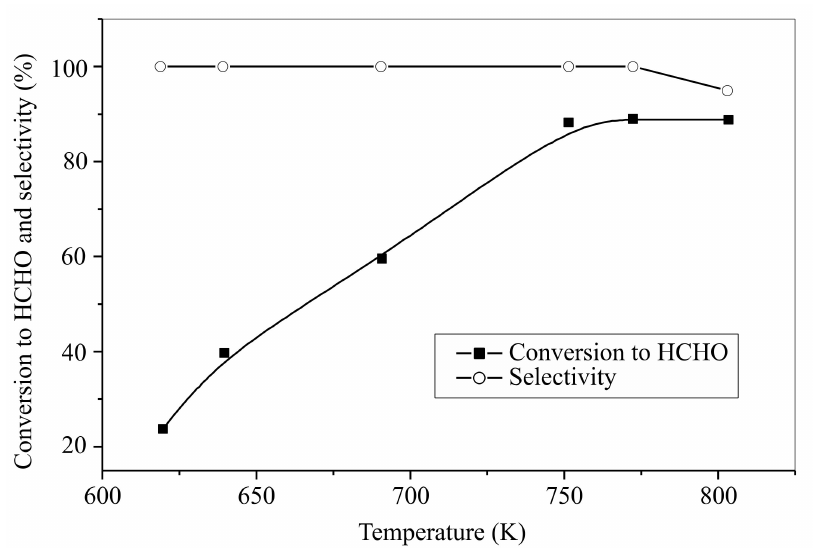
Figure 40. Temperature dependence of MeOH conversion and selectivity towards FA for FeVO 4 catalyst at flow rate of 4 mL/min, 6.5 vol.% MeOH in the feed, and 0.6 g catalyst in the reactor. Reprinted from [216] with permission from copyright